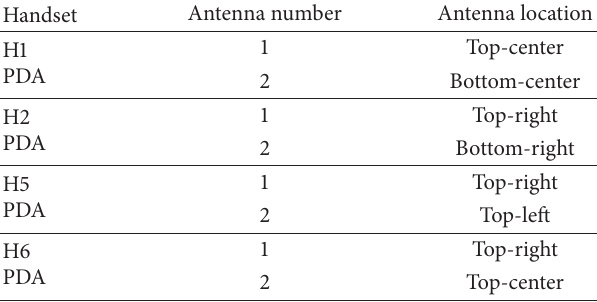
Table 1: Handsets and antennas